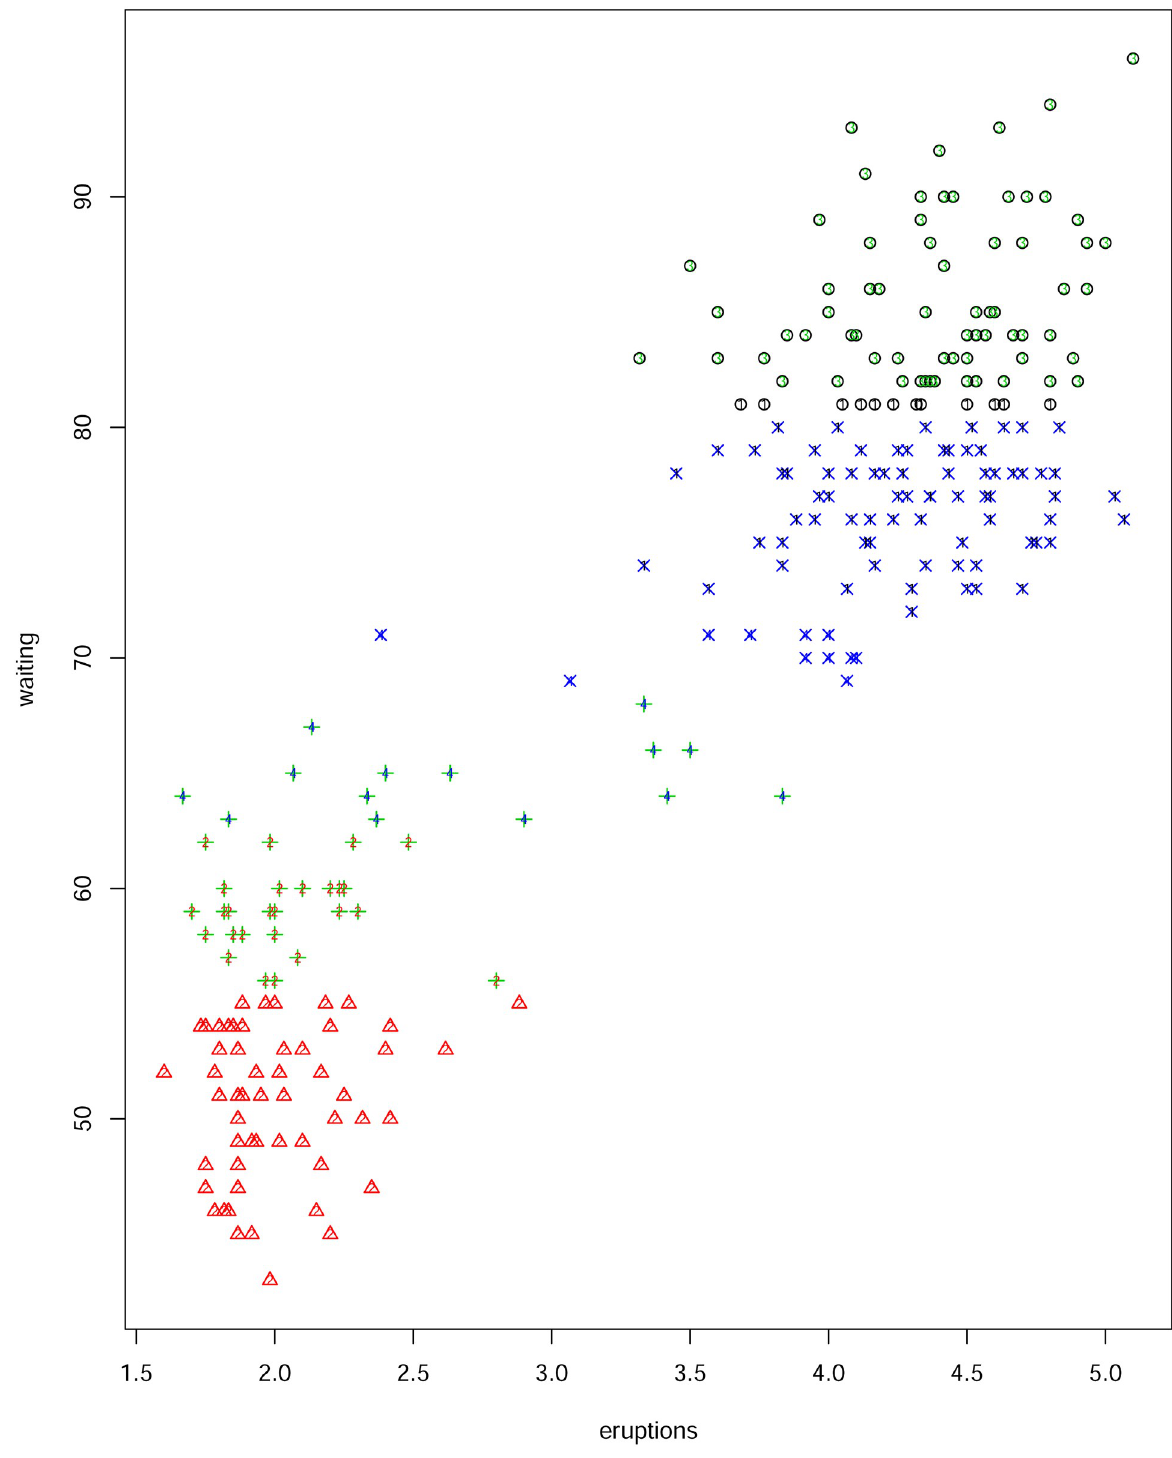
Fig 3. A comparison of the clustering in Fig 2 with the K -means output for four clusters.